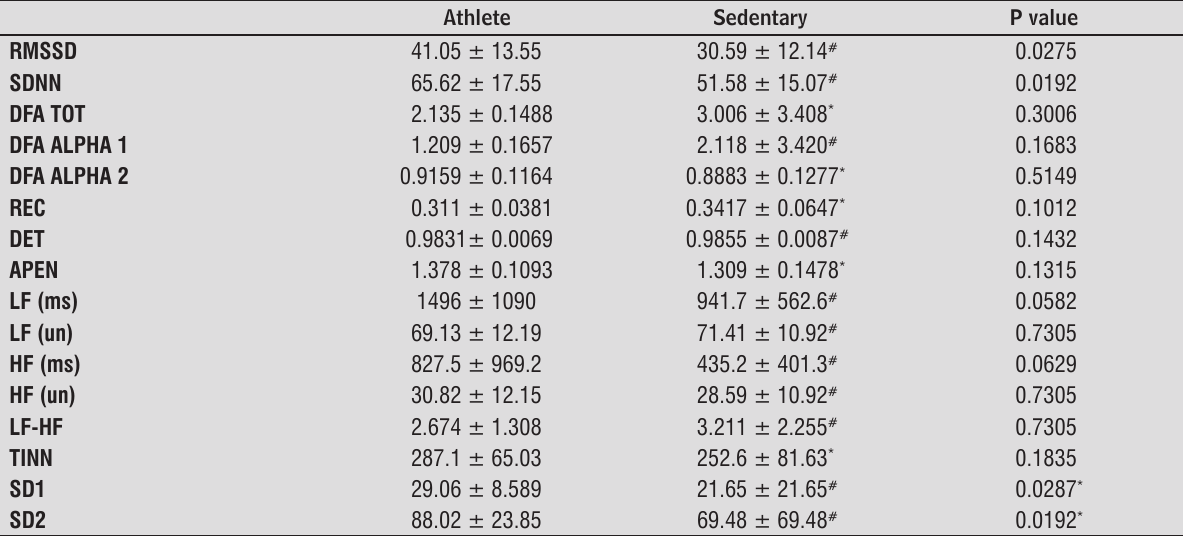
Table 4 - Mean and standard deviation of heart rate variability between the groups of athletes and sedentary individuals evaluated before the spirometric intervention and thirty minute stress test Athlete P